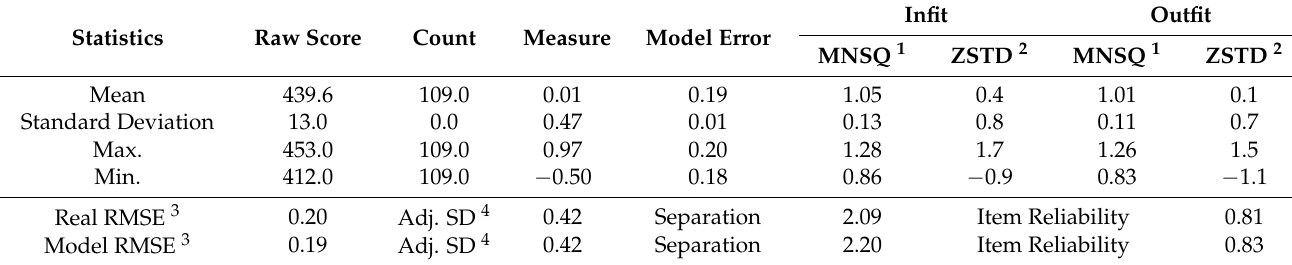
Table 11. Statistical summary of items (transformational leadership).